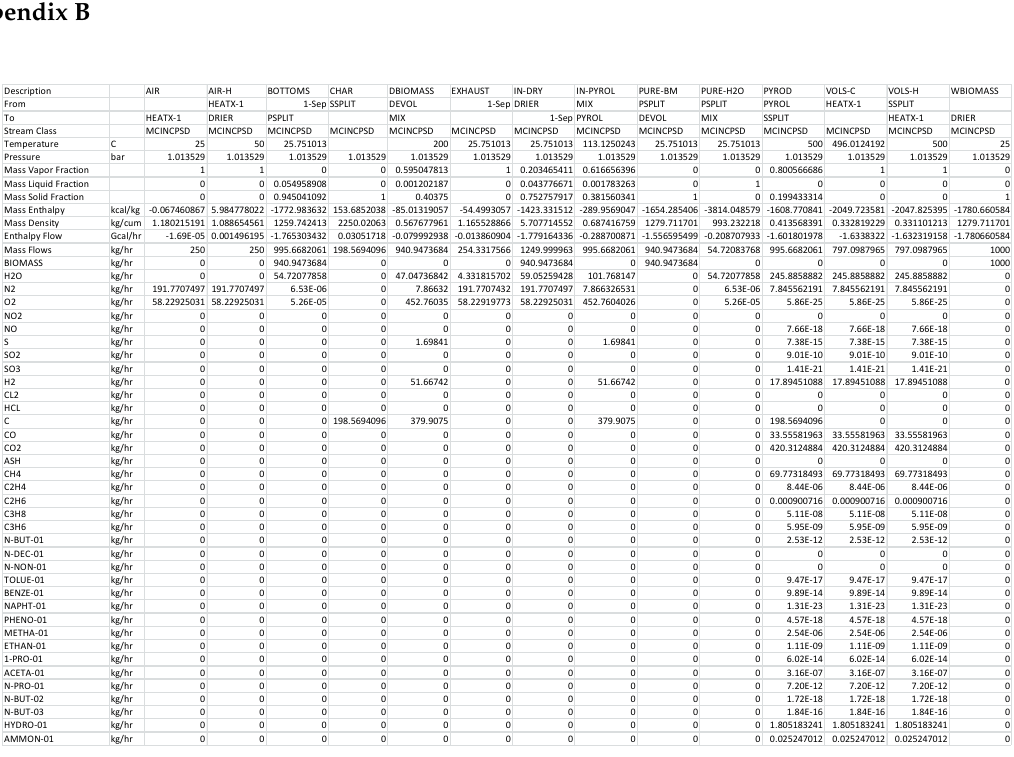
Figure A1. Pyrolysis stream results.